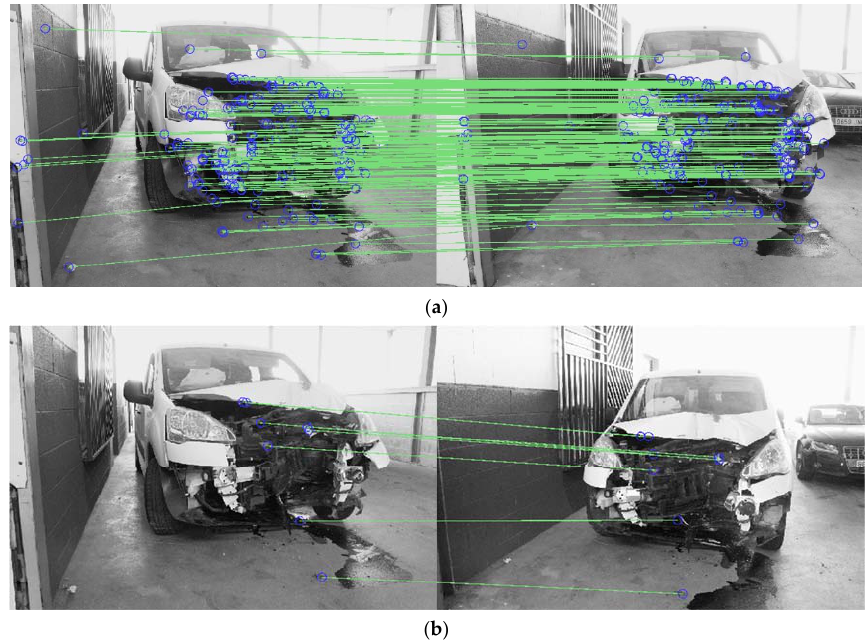
Figure 7. Results obtained during the key point extraction and matching stage: ( a ) affine maximum self-dissimilarity (AMSD) with robust matching; and ( b ) maximal self-dissimilarity (MSD) and L2-norm matching approach.